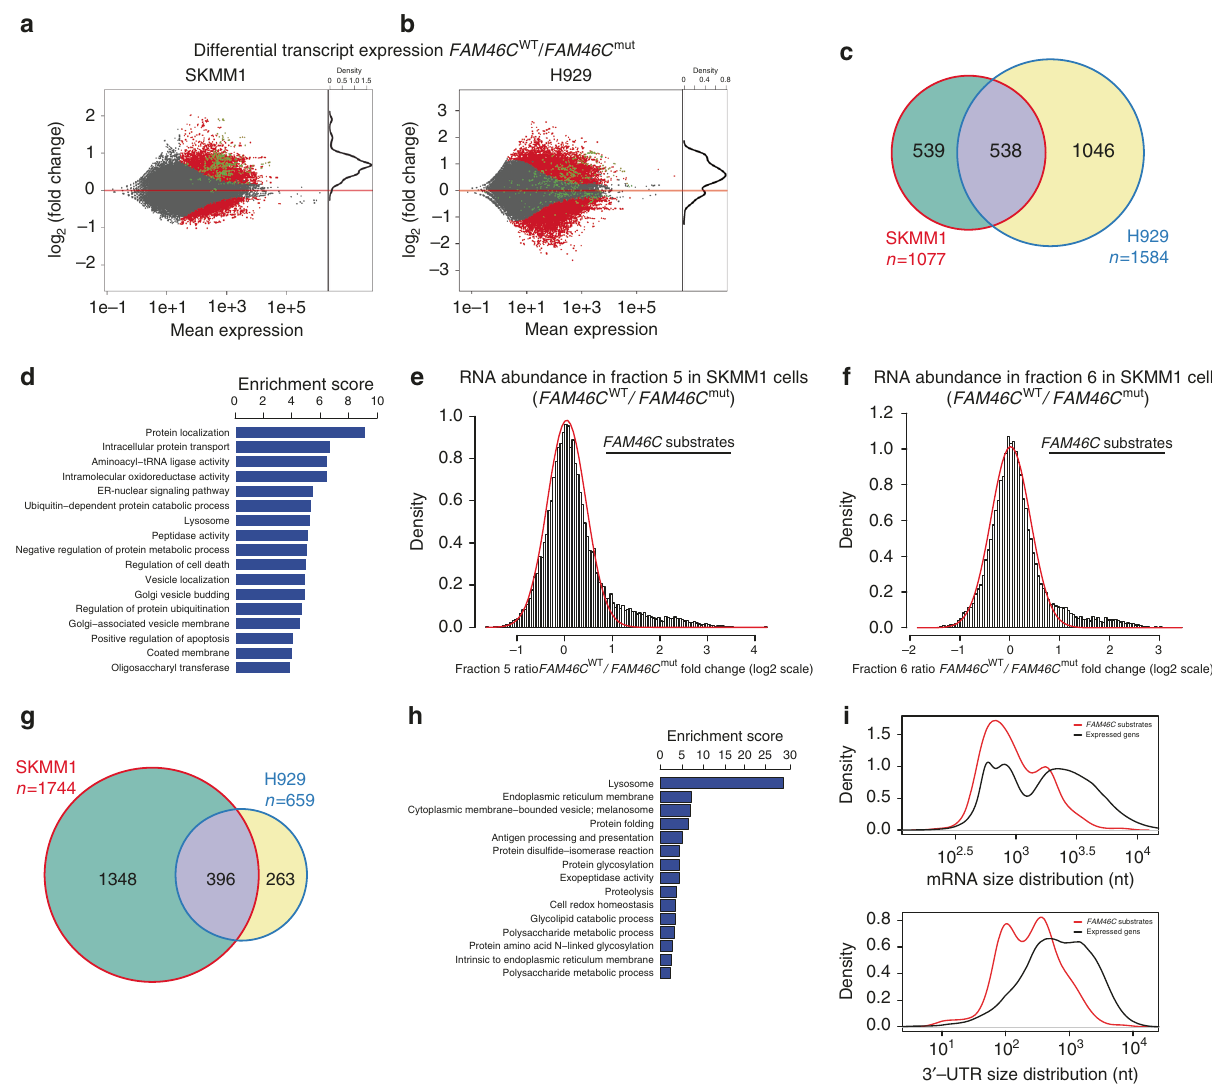
Fig. 7 Global analysis of FAM46C substrates in MM cells. a , b MAplots of total RNA sequencing results representing differential expression analysis of FAM46C WT -GFP and FAM46C mut -GFP-transduced MM cell lines. SKMM1 ( a ) and H929 ( b ) show transcriptome wide moderate deregulation of gene expression. Statistically signi fi cant values (FDR < 1%) are shown in red . The 396 transcripts constituting the common part for SKMM1 and H929 MM cell lines are marked with green circles . c Venn diagram demonstrating the overlap between upregulated transcripts in SKMM1 and H929 MM cell lines. d Functional GO terms annotation clustering of signi fi cantly upregulated transcripts in both MM cell lines. e , f Histogram representing the distribution of FAM46C-dependent polyadenylation rations monitored in fraction #5 ( e ) and #6 ( f ) in SKMM1 cell lines. Modeled normal distribution is fi tted as a red line to emphasize the outlying population of FAM46C polyadenylated transcripts. g Venn diagram demonstrating the overlap between transcripts shifting to both long poly(A) fractions in FAM46 WT overexpressing cells mutually in SKMM1 and H929 MM cell lines. h 396 transcripts constituting the common part for SKMM1 and H929 MM cell lines were used in DAVID Functional Annotation Clustering Analysis. i The same set of transcripts was used to characterize the 3 ′ -UTRs and total mRNA lengths showing a bias towards shorter species in